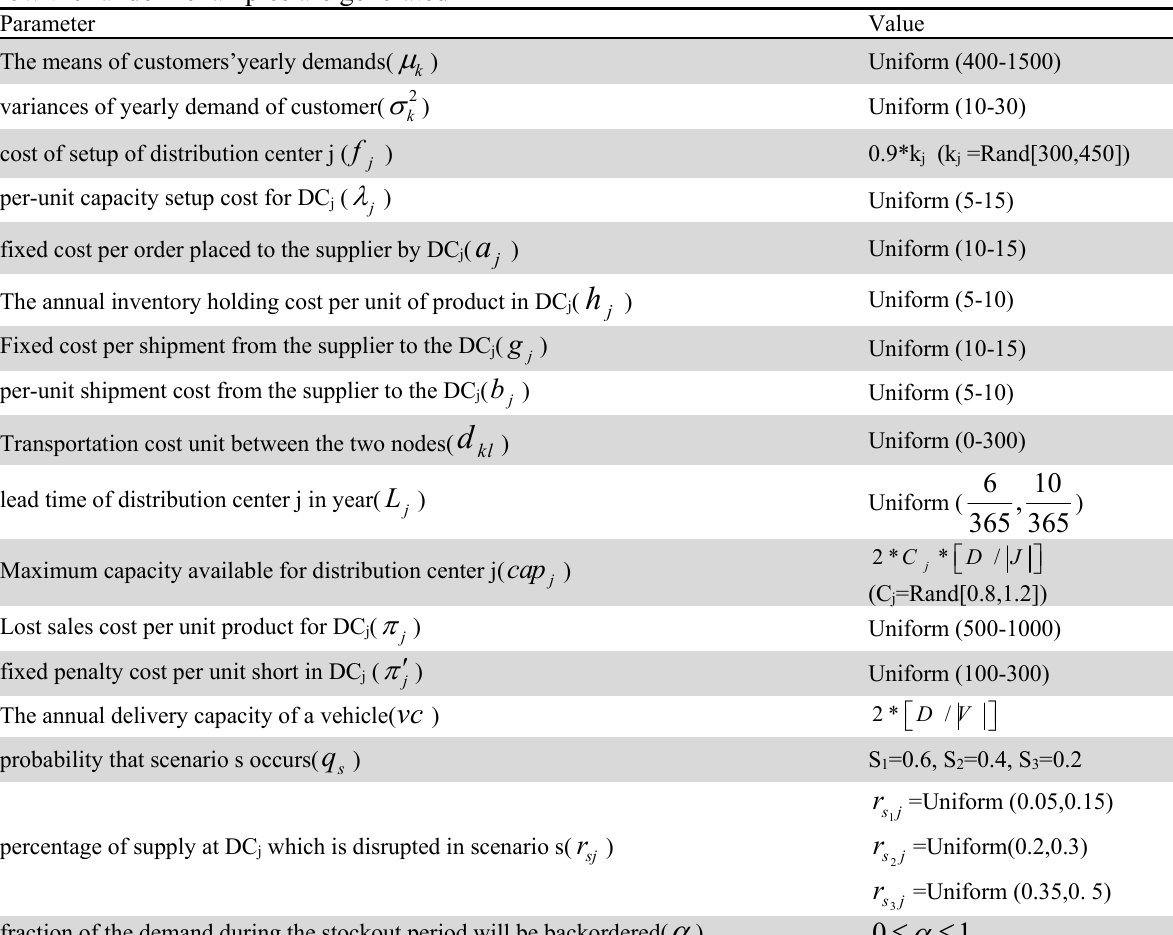
Table 1 How the random examples are